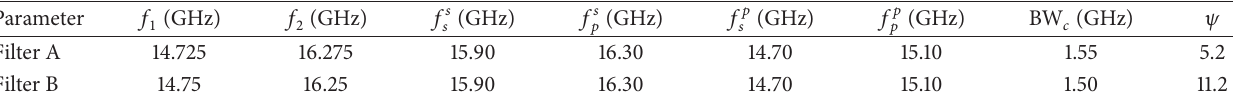
Table 2: FBAR filters design parameters.